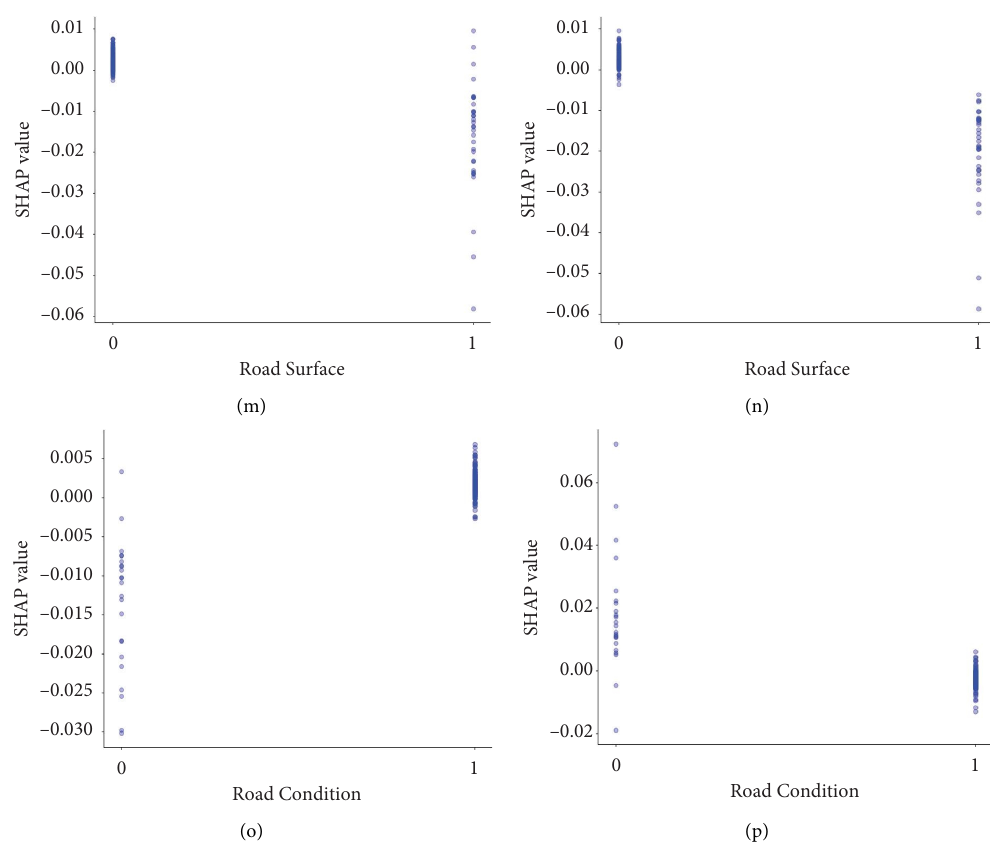
Figure 10: SHAP main efects of variables on the time gap and the distance gap. (a) Population on the time gap. (b) Population on the distance gap. (c) Weekend on the time gap. (d) Weekend on the distance gap. (e) Peak on the time gap. (f) Peak on the distance gap. (g) Collision type on the time gap. (h) Collision type on the distance gap. (i) Weather on the time gap. (j) Weather on the distance gap. (k) Alcohol involved on the time gap. (l) Alcohol involved on the distance gap. (m) Road surface on the time gap. (n) Road surface on the distance gap. (o) Road condition on the time gap. (p) Road condition on the distance gap. 1.0 0.3 0.8